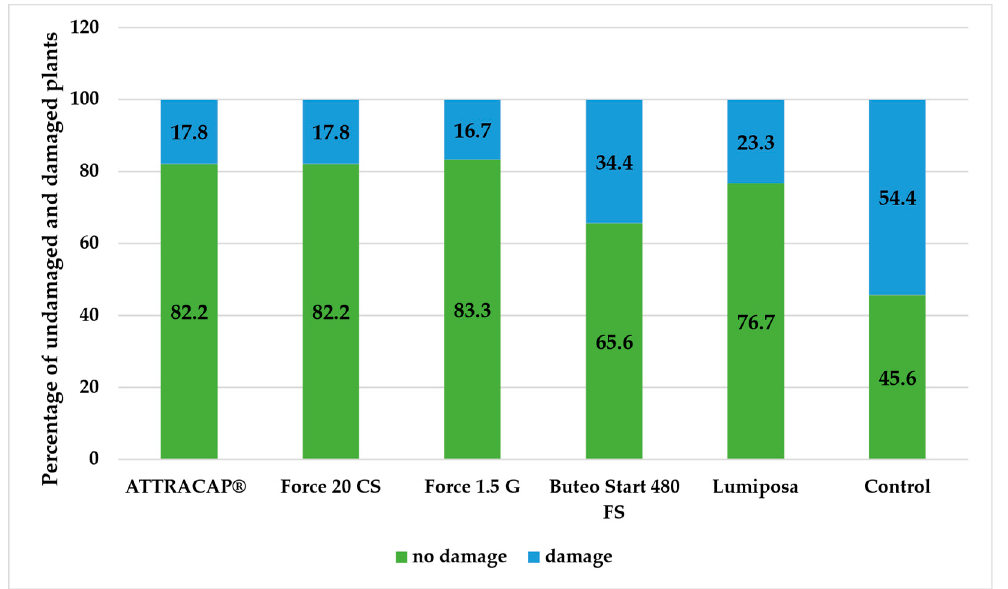
Figure 6. Percentage of undamaged and damaged plants in different insecticidal treatments in the sunflower field RŠ T-12 in the year 2021.